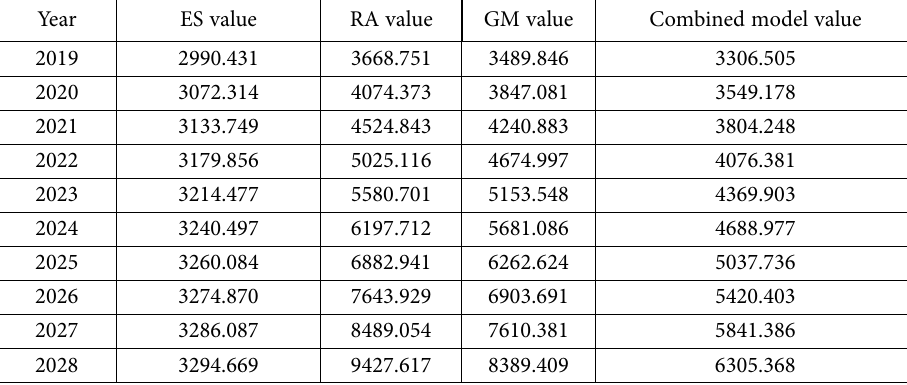
Year ES value RA value GM value Combined model